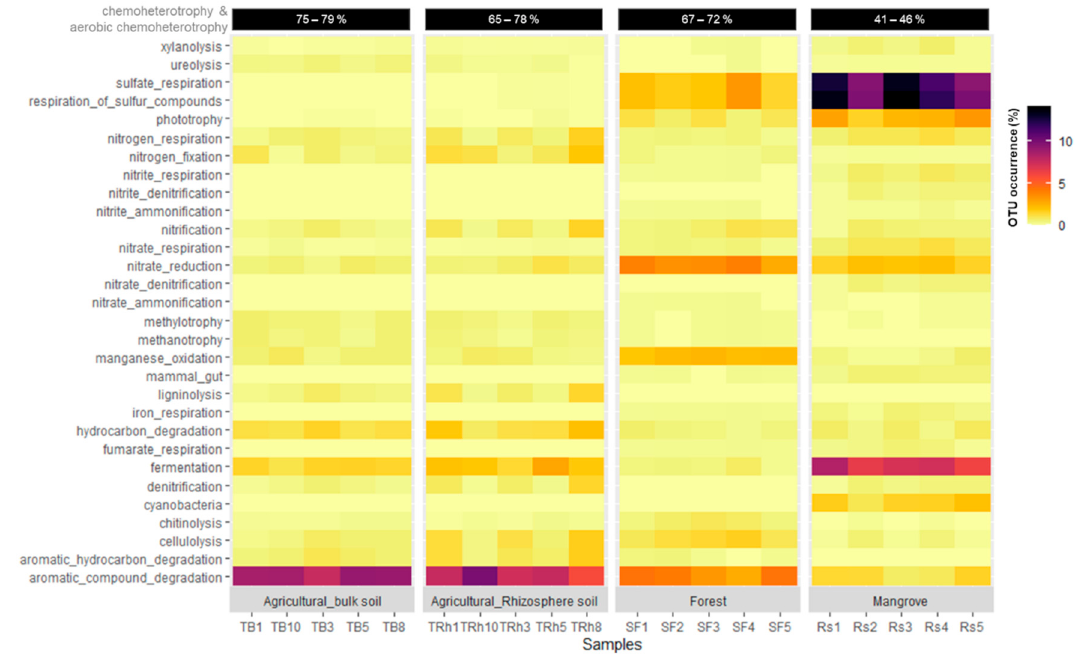
Figure 3. Heatmap of metabolic phenotypes/functions of bacteria. The data based on OTUs occurrence (number of OTUs capable for each function) derived from agricultural bulk soil (TB), agricultural rhizosphere soil (TRh), forest soil (SF) and mangrove-rhizosphere soil (Rs) samples.